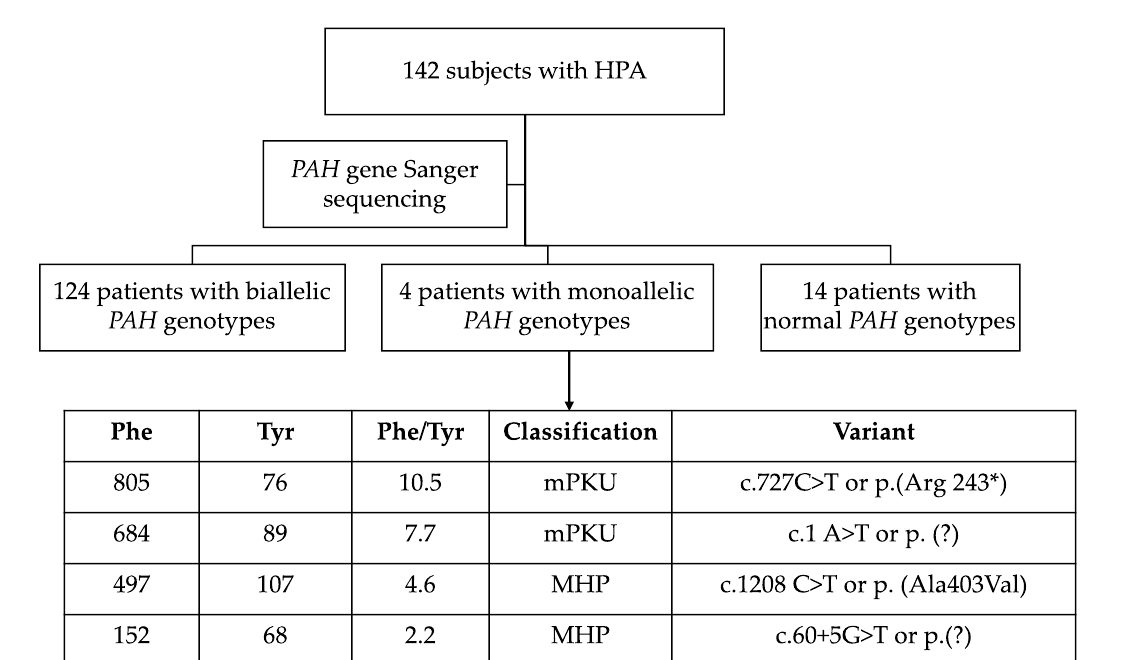
Figure 1. Workflow scheme for inclusion in the present study of 124 patients bearing PAH biallelic genotypes. The biochemical characteristics of the four identified patients bearing monoallelic PAH genotypes are shown. The 14 patients with normal PAH genotypes are currently under study for BH 4 defects. Abbreviations: HPA: hyperphenylalaninemia; PAH: phenylalanine hydroxylase gene; Phe: phenylalanine; Tyr: tyrosine; mPKU: mild phenylketonuria; MHP: mild